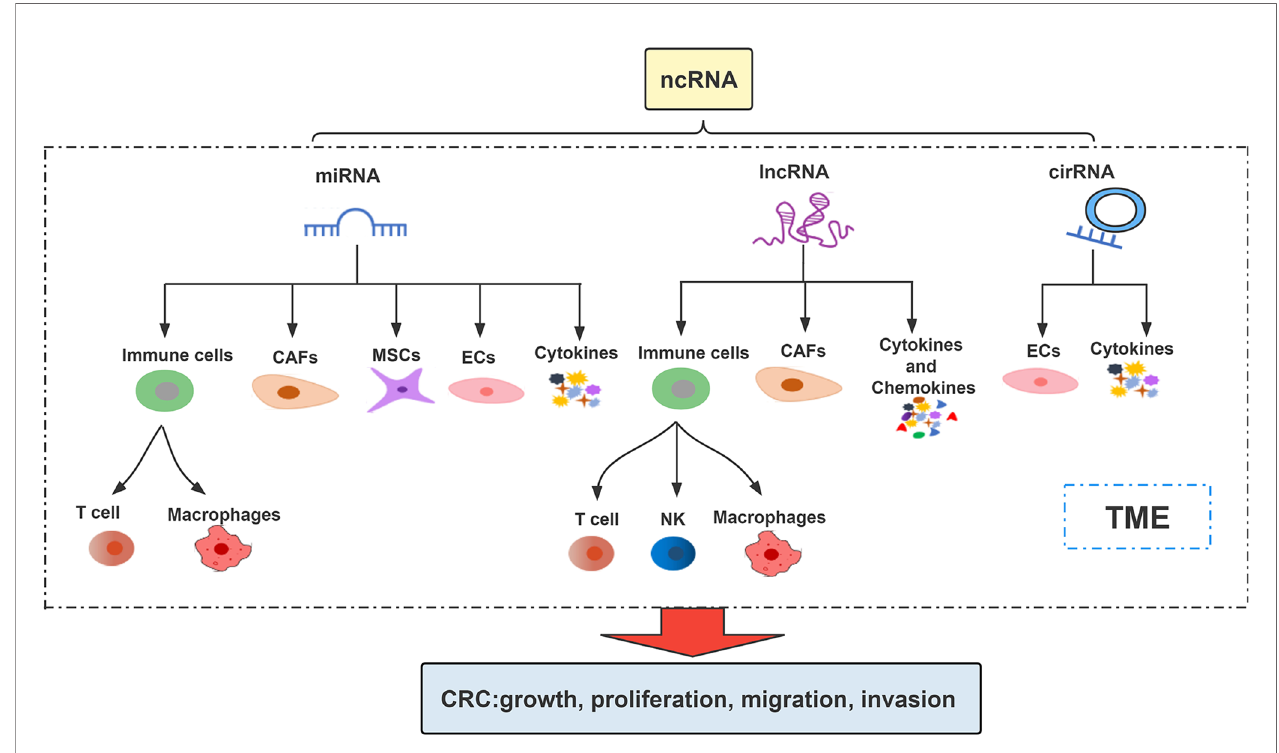
FIGURE 1 | Important roles of ncRNAs in the